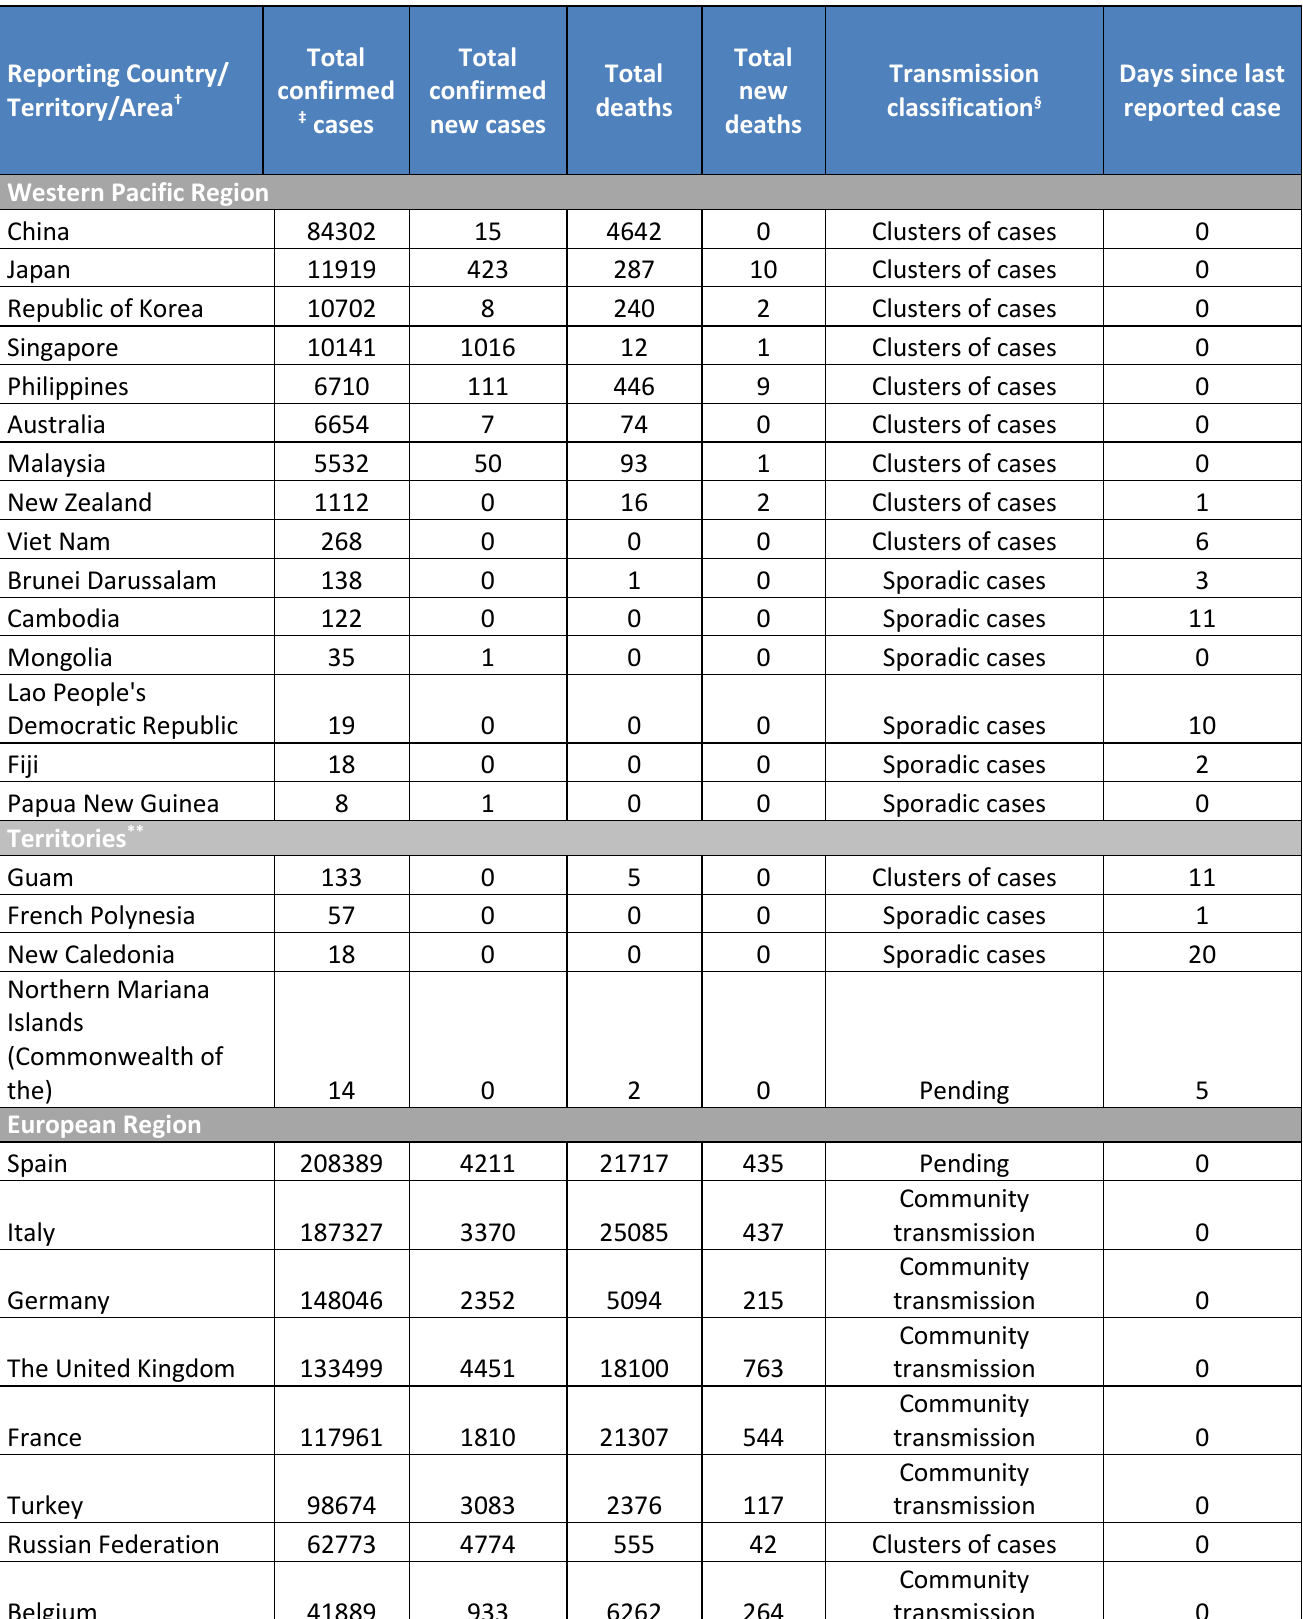
Table 1. Countries, territories or areas with reported laboratory-confirmed COVID-19 cases and deaths. Data as